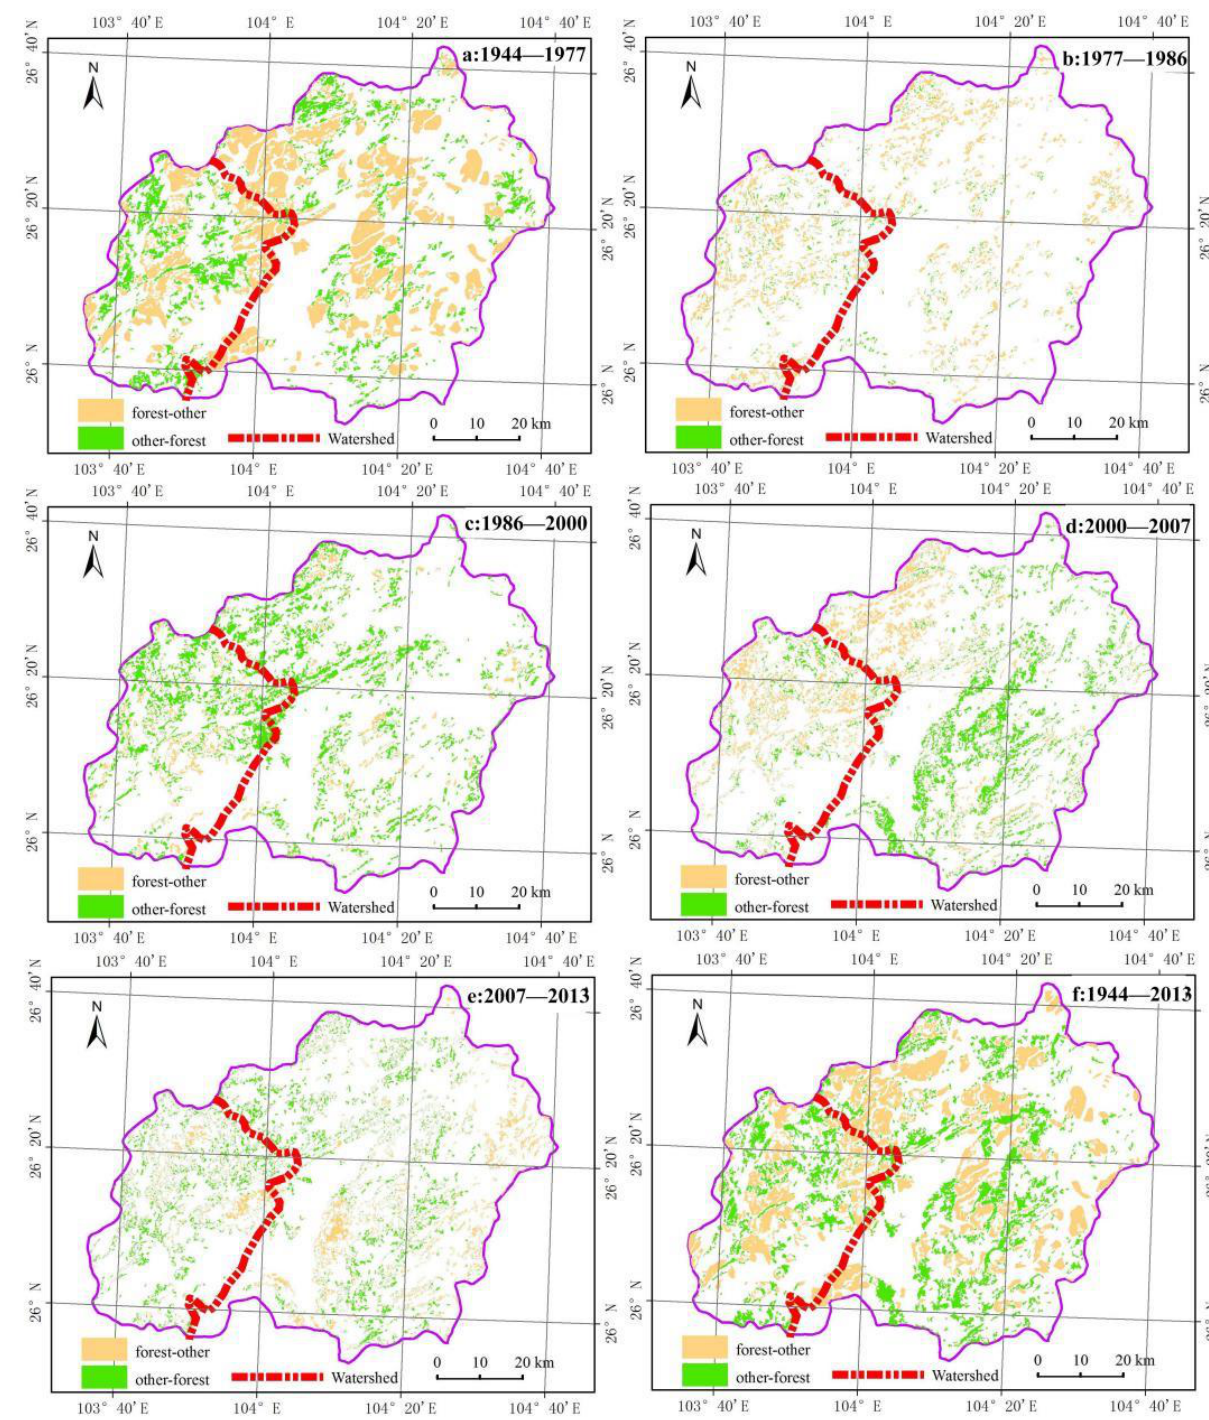
Figure 6. The space transfer matrix maps of forest landscape in different historical periods. (We constructed this map using ArcGIS9.3 (http://www.esri.com/arcgis/about-arcgis) (accessed on 27 December 2021))